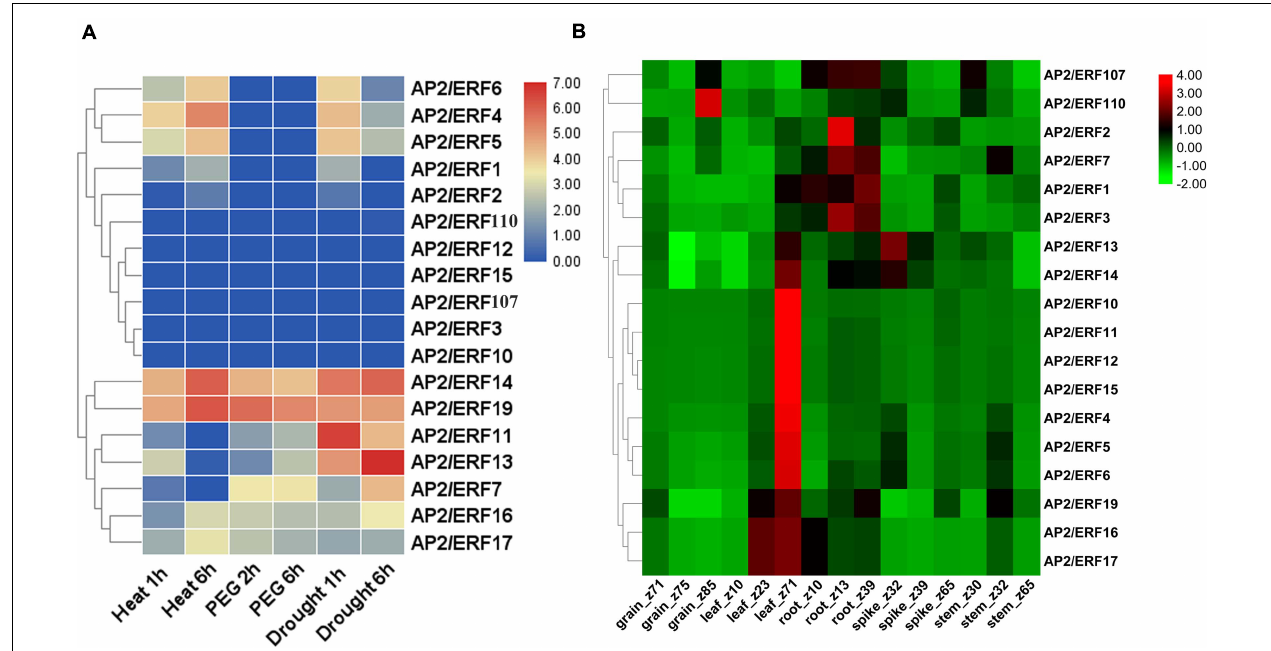
FIGURE 6 | Heat map of TaAP2/ERF genes in Wheat under different abiotic stresses and various tissues at different developmental stages. (A) The TPMs were calculated for expression values from RNA-seq data. Different colors represent expression level; The red, violet, and blue color indicated high expression, low expression, and no expression, respectively. (B) Log 2 transformed (FPKM + 1) expression values were used to create the heat map. The highest level of expression is represented by red, while the low level is represented by